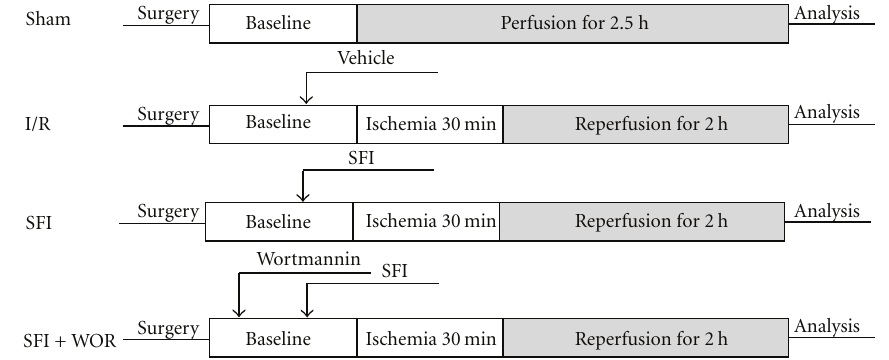
Figure 1: Experimental protocols. Diabetic rats were subjected to 30 min of coronary artery occlusion followed by 2h of reperfusion. SFI was applied 10 minutes before ischemia. Wortmannin was applied 20 minutes prior to ischemia. I/R: ischemia/reperfusion; SFI: Shen-fu injection; WOR: wortmannin.